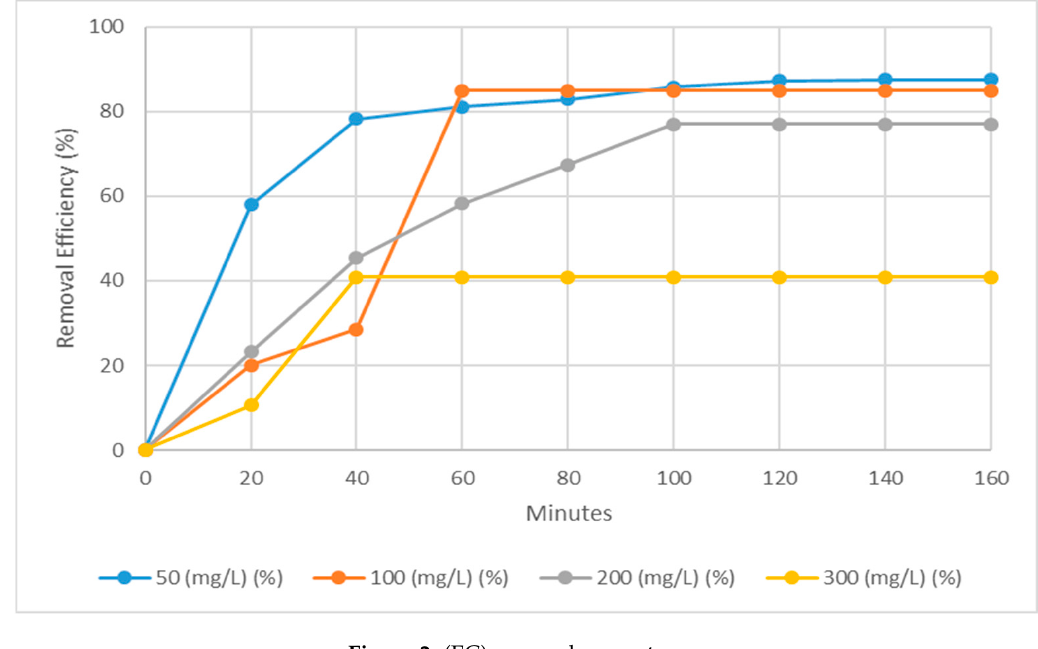
Figure 2. (EC) removal percentages.